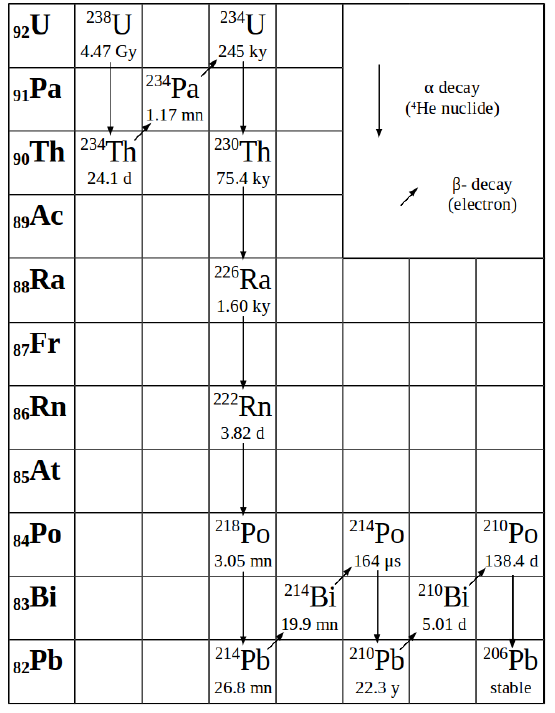
Figure 1. 238 U decay chain. Half-lives are indicated beneath the symbol of the element. Minor embranchments are not reproduced.